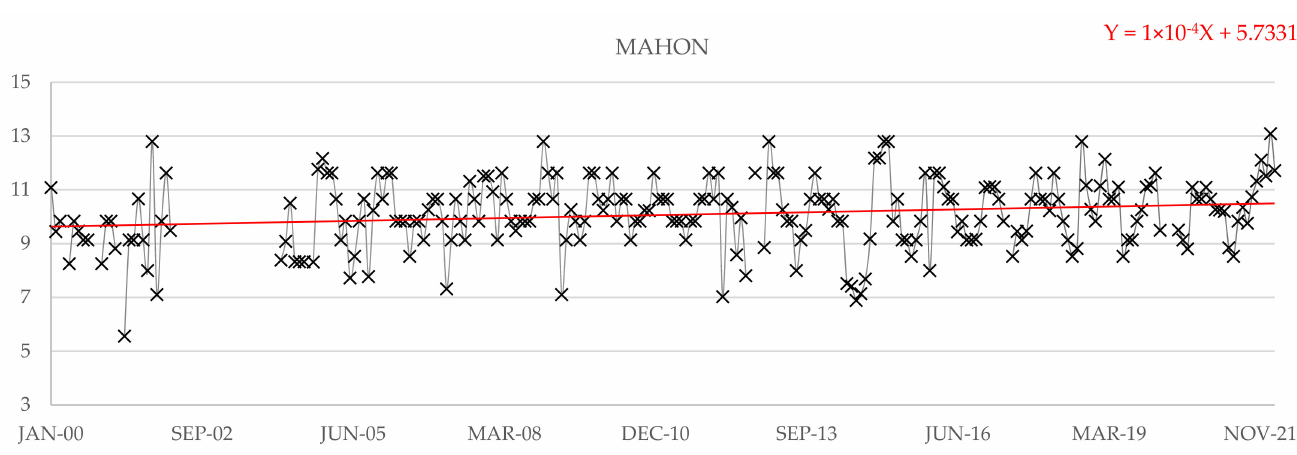
Figure 16. Evolution of Tp maxima in